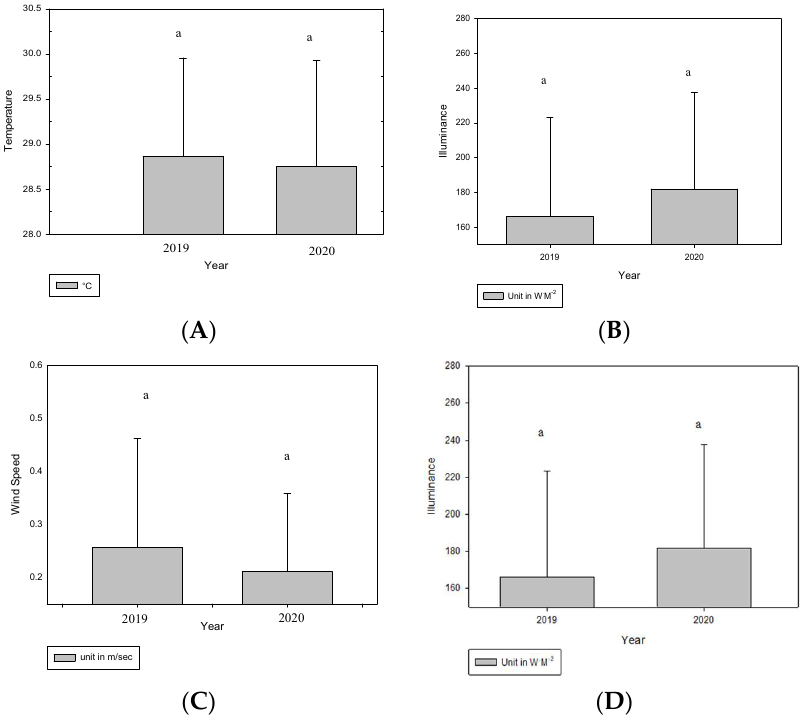
Figure 2. Comparison of the weather conditions between 2019 and 2020. ( A ) Temperature; ( B ) hu- midity; ( C ) wind speed; ( D ) illuminance. Lowercase letters indicate significant differences among treatments for a given trait ( p < 0.05; LSD test). There were no significant changes between the 2 years. Least significant difference (LSD). p < 0.05.